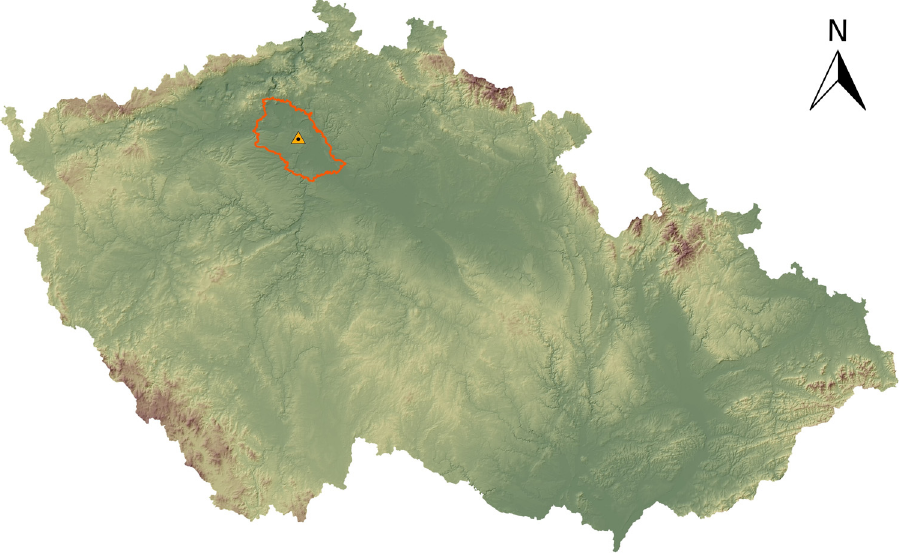
Figure 4: Location of the research area within the current boundaries of the Czech